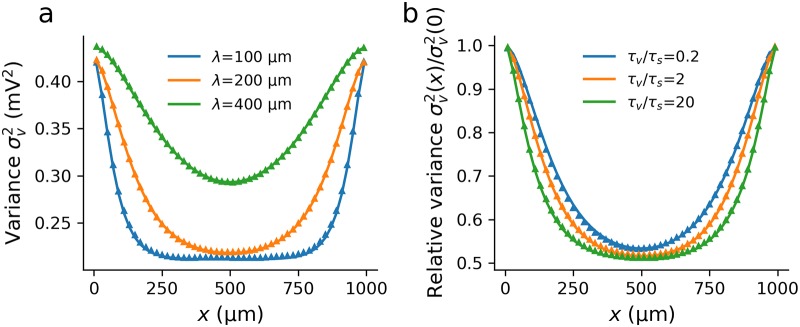
The variance profile in a sealed dendrite is a function of both the electrotonic length λ and ratio of synaptic to voltage time constants τs/τv.(a) The variance near the sealed end is higher than in the bulk with the extent of the boundary effect decreasing with λ. (b) Normalizing the variance in the cable such that the variance at the ends is unity, it can be seen that increasing τv/τs decreases the effective length constant. For both plots the other parameters were L = 1000μm, τs = 5ms, σs = 1mV. (a) τv = 10ms, (b) λ = 200μm.